Question: Judging by this figure, is the value going up or going down?
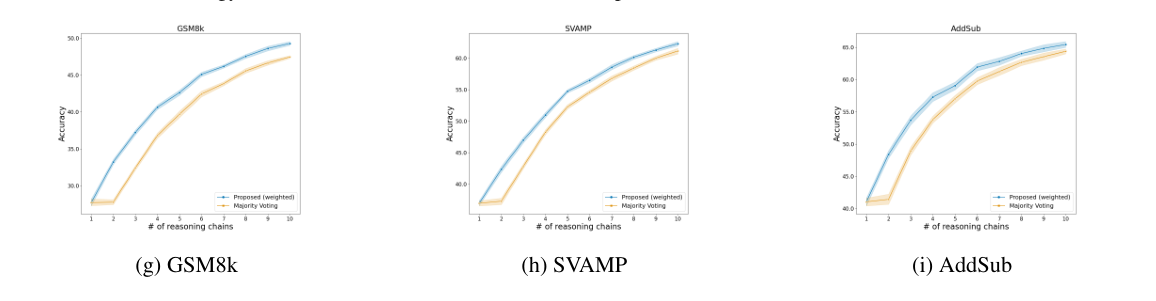
Answer: increasing